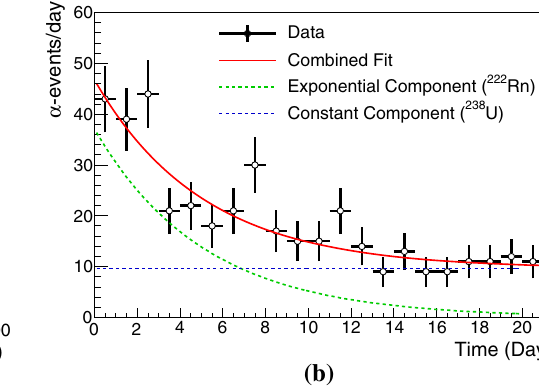
table supports the crystal assemblies. The eight crystals are labeled C1 through C8 and the locations of the four calibration holes are indicated. The table dimensions are indicated in mm and viewed from the A-side of the detector